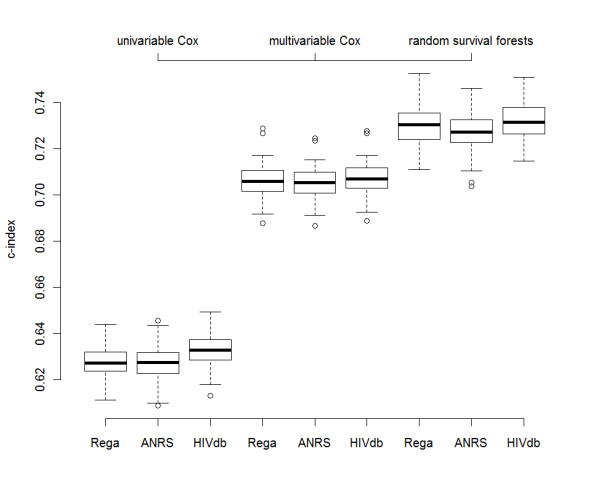
Extra-sample performance evaluation of Cox regression and Random Survival Forests models by means of c-index distributions (100 bootstrap runs). Boxplots indicate average and interquartile range, whilst whiskers indicate 95% confidence intervals.